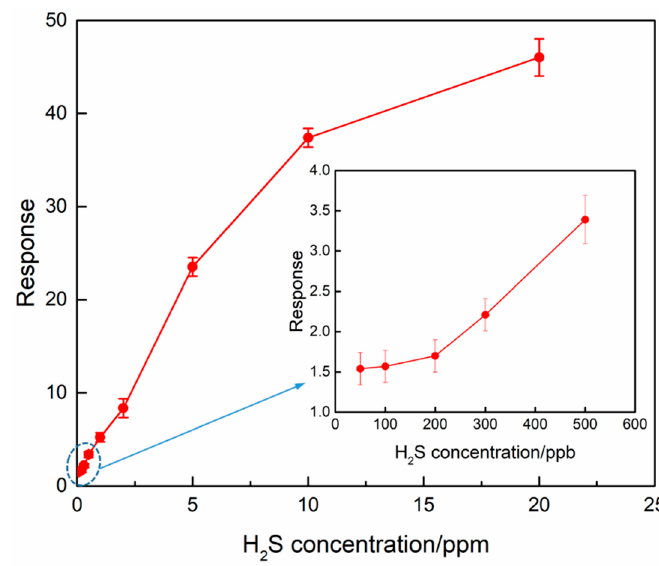
Figure 9. Responses of 1% Zn-doped α -Fe 2 O 3 nanowires upon exposure to various H 2 S concentrations at the operating temperature of 175 °C.